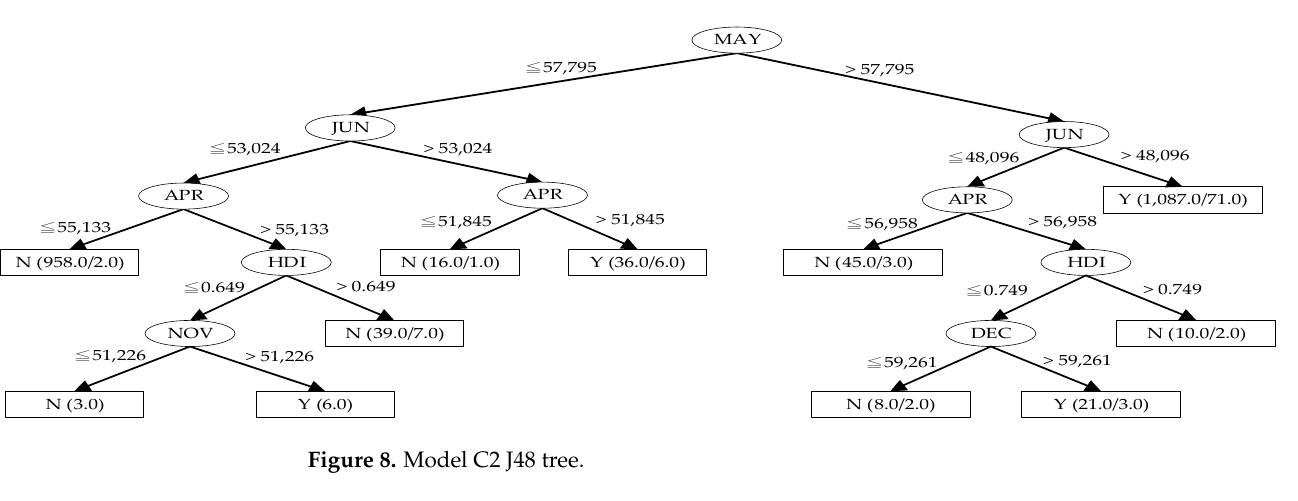
Figure 8. Model C2 J48 tree.